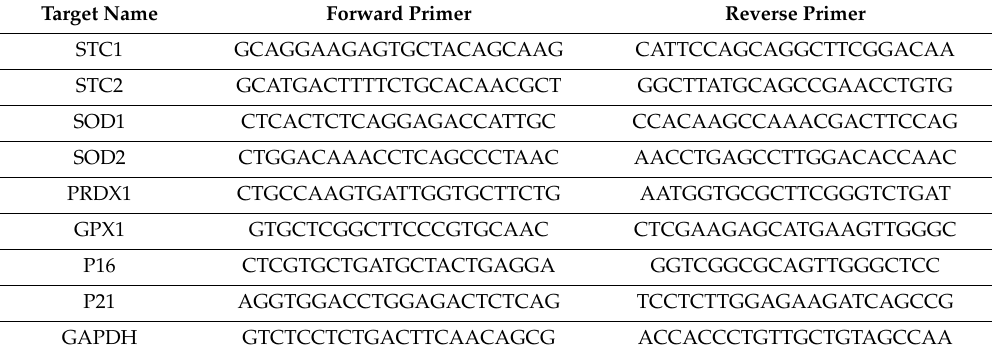
Table 1. Primer sequences for